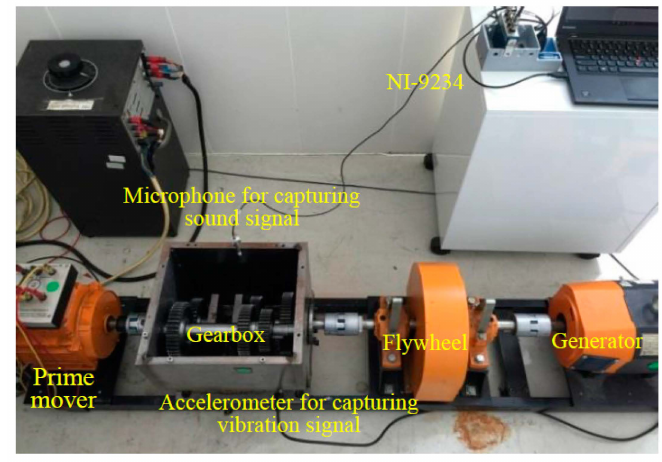
Figure 7. Collection of fault patterns from a rotating